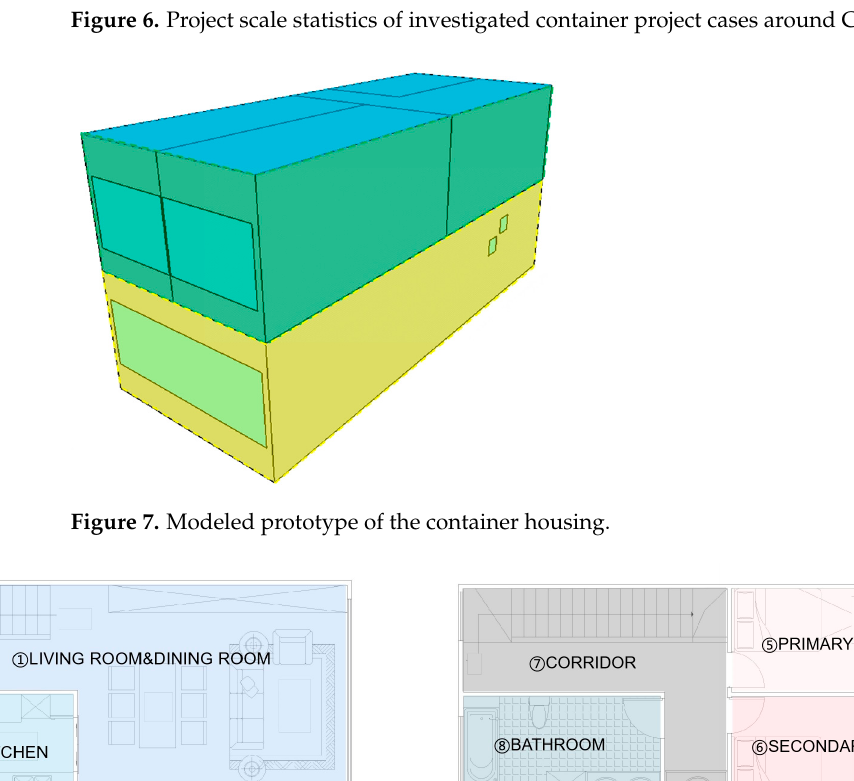
Figure 7. Modeled prototype of the container housing.